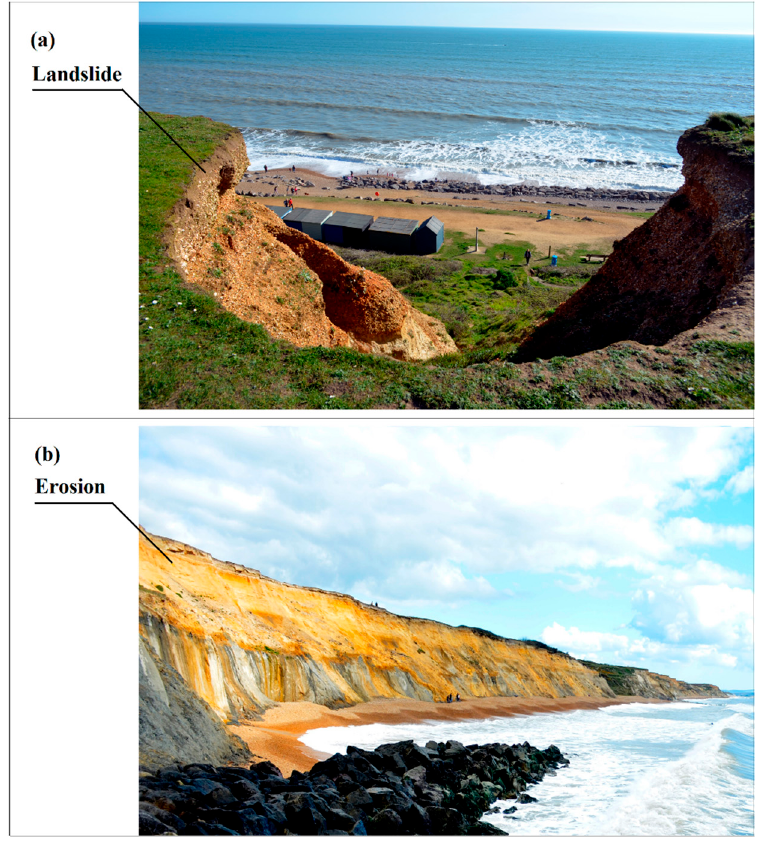
Figure 3. Barton-on-Sea: Landslide and coastal erosion damage along the shoreline in March 2017. ( a ) Landslide’s damage; ( b ) Coastal erosion.